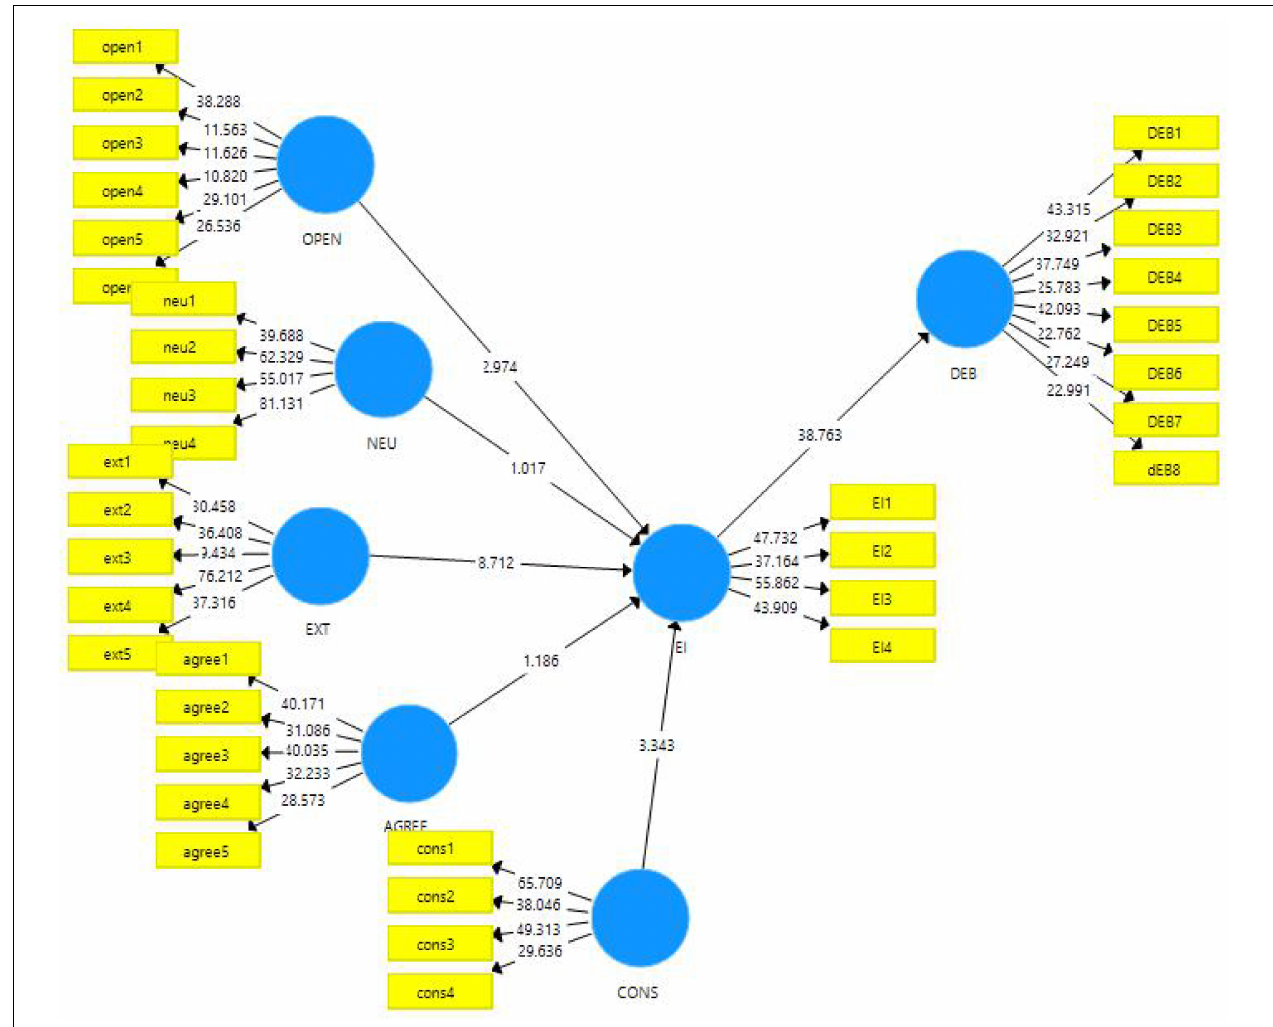
FIGURE 4 | PLS-structural model algorithm